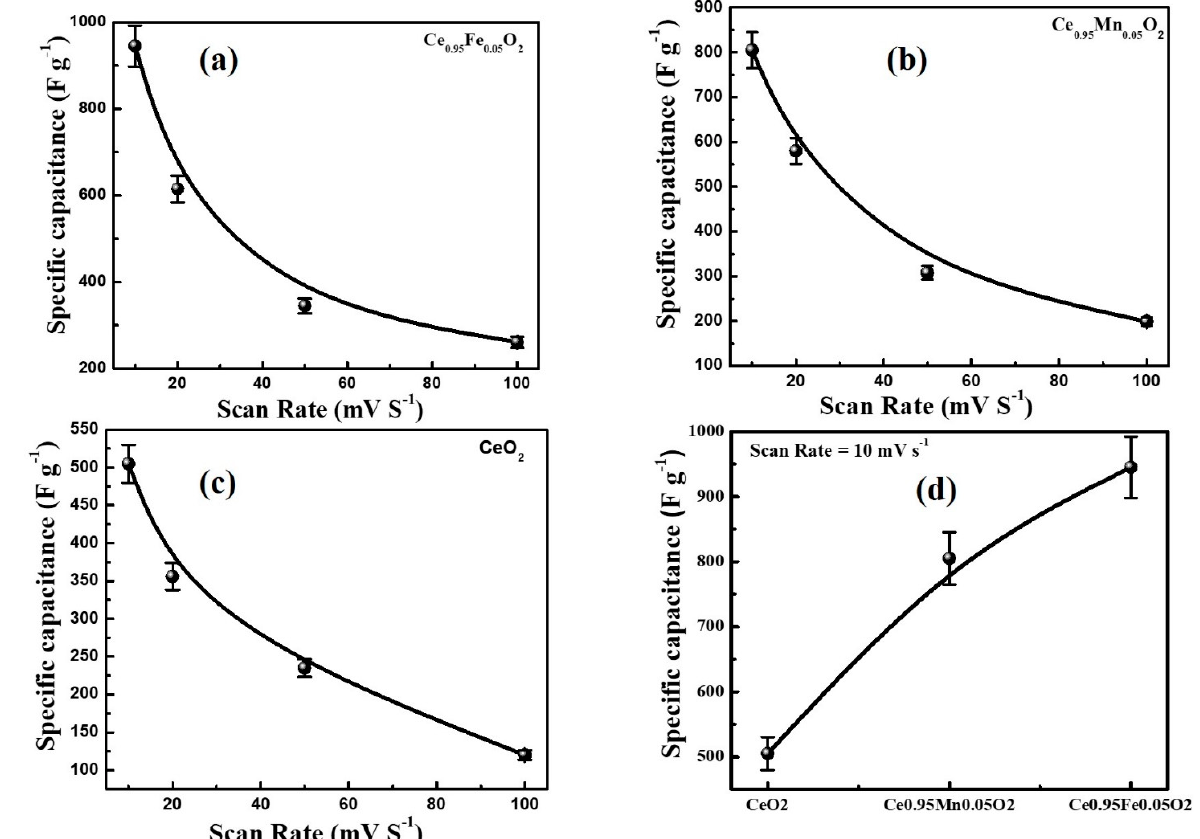
Figure 9. The specific capacitance of ( a ) CeO 2 nanoparticles, ( b ) Ce 0.95 Mn 0.05 O 2 nanoparticles, ( c ) Ce 0.95 Fe 0.05 O 2 nanoparticles with different scan rate ( d ) Variation in specific capacitance of CeO 2 , Ce 0.95 Mn 0.05 O 2 , Ce 0.95 Fe 0.05 O 2 nanoparticles at a scan rate of 10 mV S − 1 .